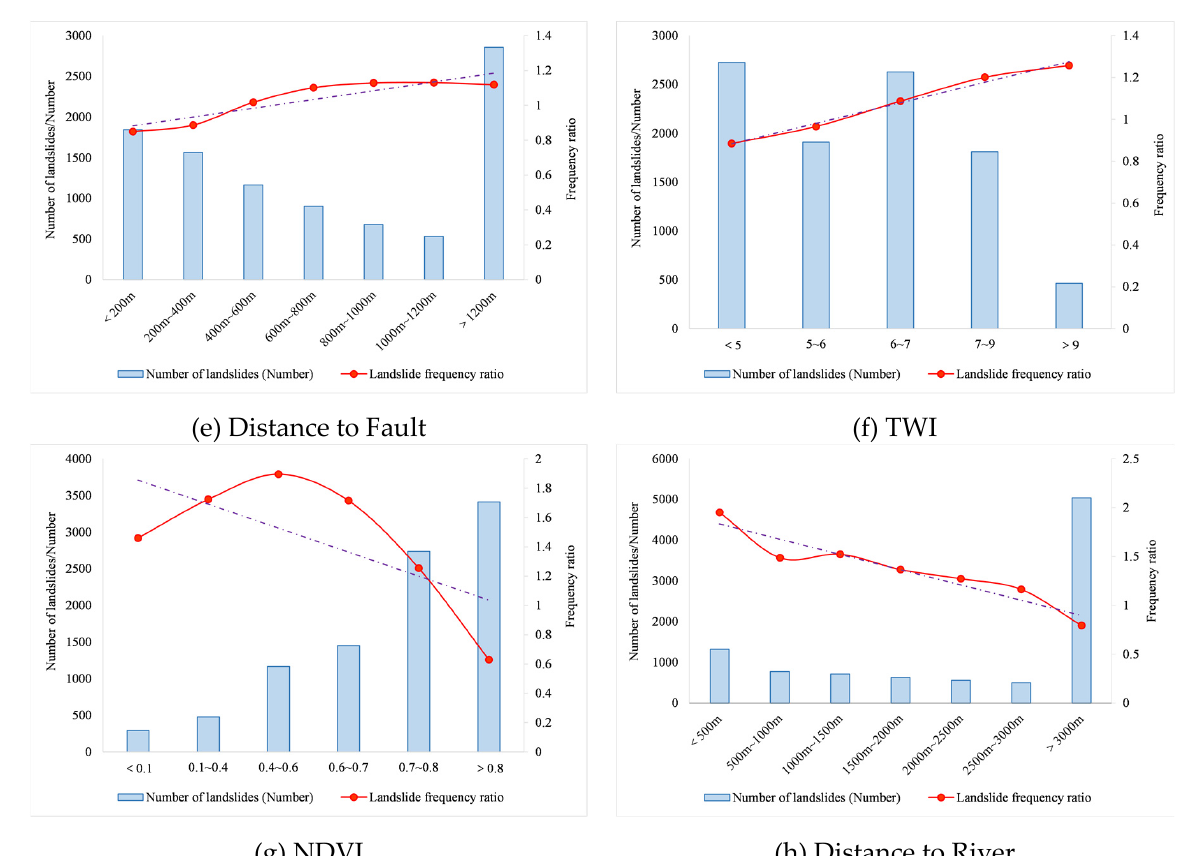
Figure 6. Landslide histogram of different indicator factors.